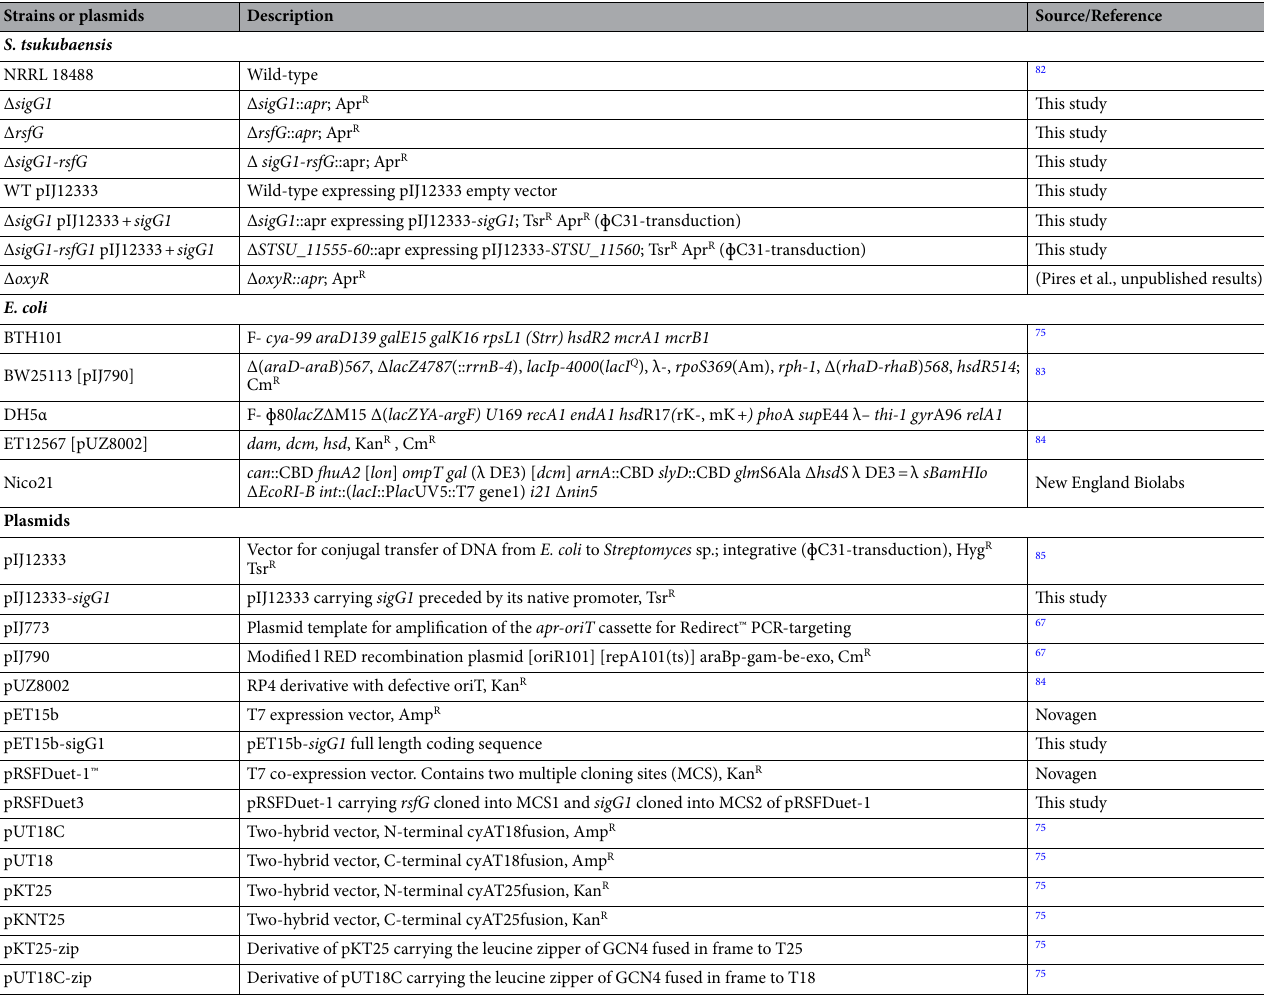
Table 3. Strains and plasmids used in this